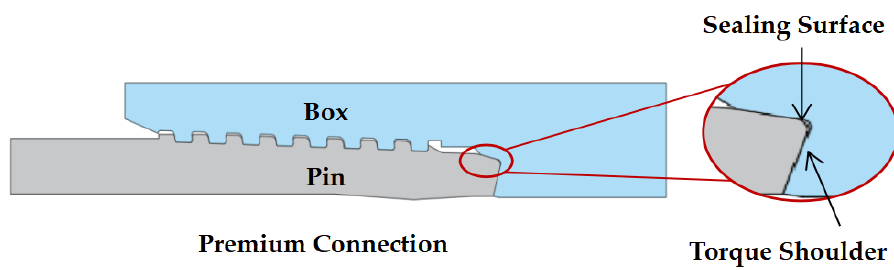
Figure 2. Schematic diagram of premium connection.